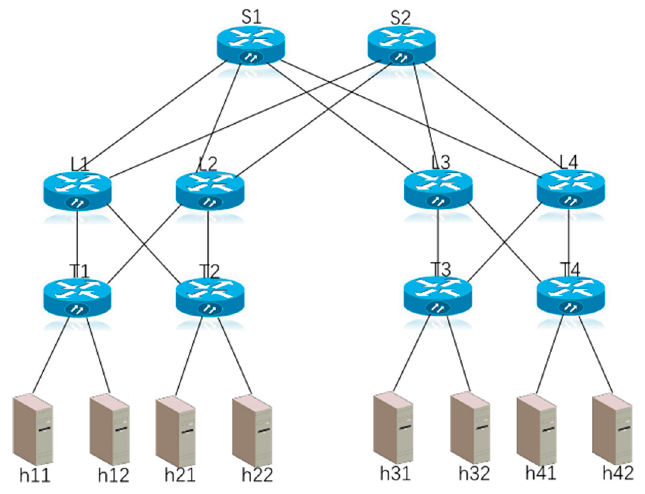
Figure 10. Testbed topology. Figure 10. Testbed